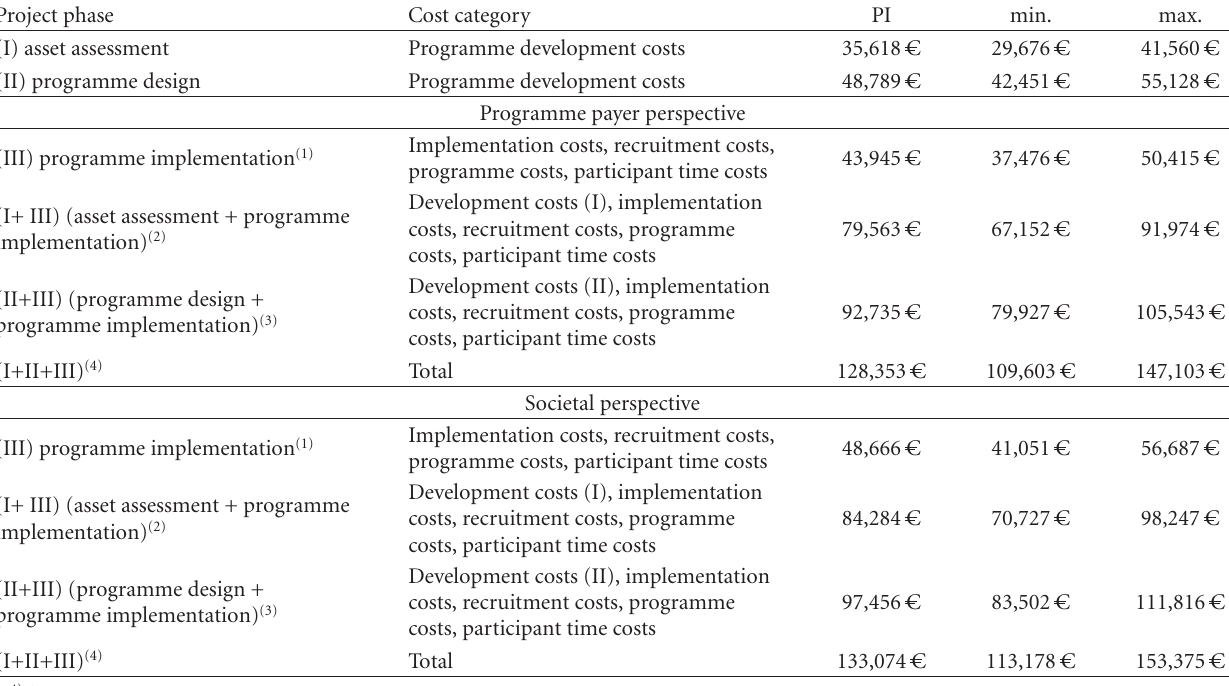
Table 7: Summary of the costs (C) of the physical activity programme di ff erentiated in the special decision context and perspective. Project